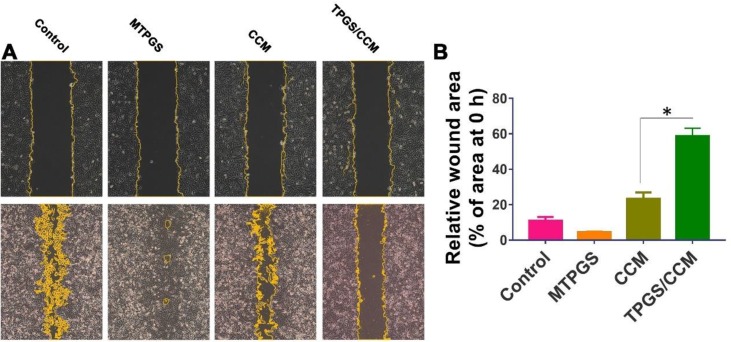
Wound healing assay in HT-29 cells treated for 48 h with TPGS/CCM, MTPGS, free CCM, or no treatment (control). (A) Phase-contrast micrographs of the wound area at 0 h (upper row) and 48 h (lower row) later. Magnification, 100X. Cell edges along the scratch are falsely colored brown for visibility. (B) Quantitation of the wound area in each treatment group at 48 h, expressed as a percentage relative to the wound size at time 0. *p < 0.05.